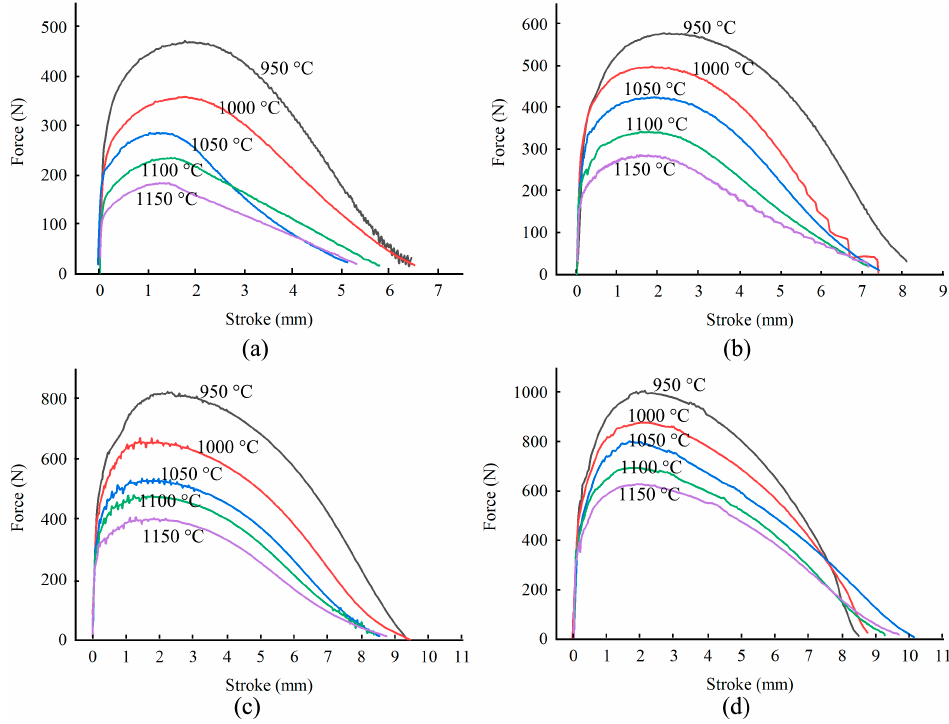
Figure 3. Force–stroke curve during tensile test. ( a ) 0.01 s − 1 , ( b ) 0.1 s − 1 , ( c ) 1 s − 1 , ( d ) 10 s − 1.